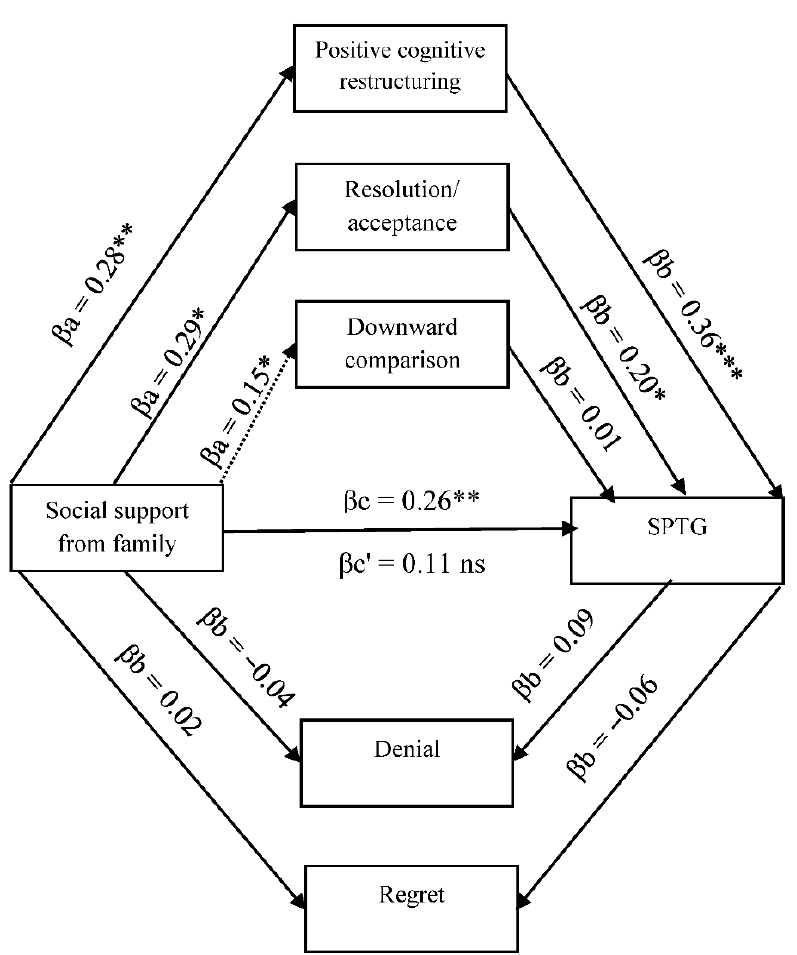
Figure 3. Model of relations between social support from family, cognitive processing of trauma and secondary posttraumatic growth. β a,b—indirect effect; β c—total effect; β c’—direct effect. * p < 0.05; ** p < 0.01; *** p < 0.001.